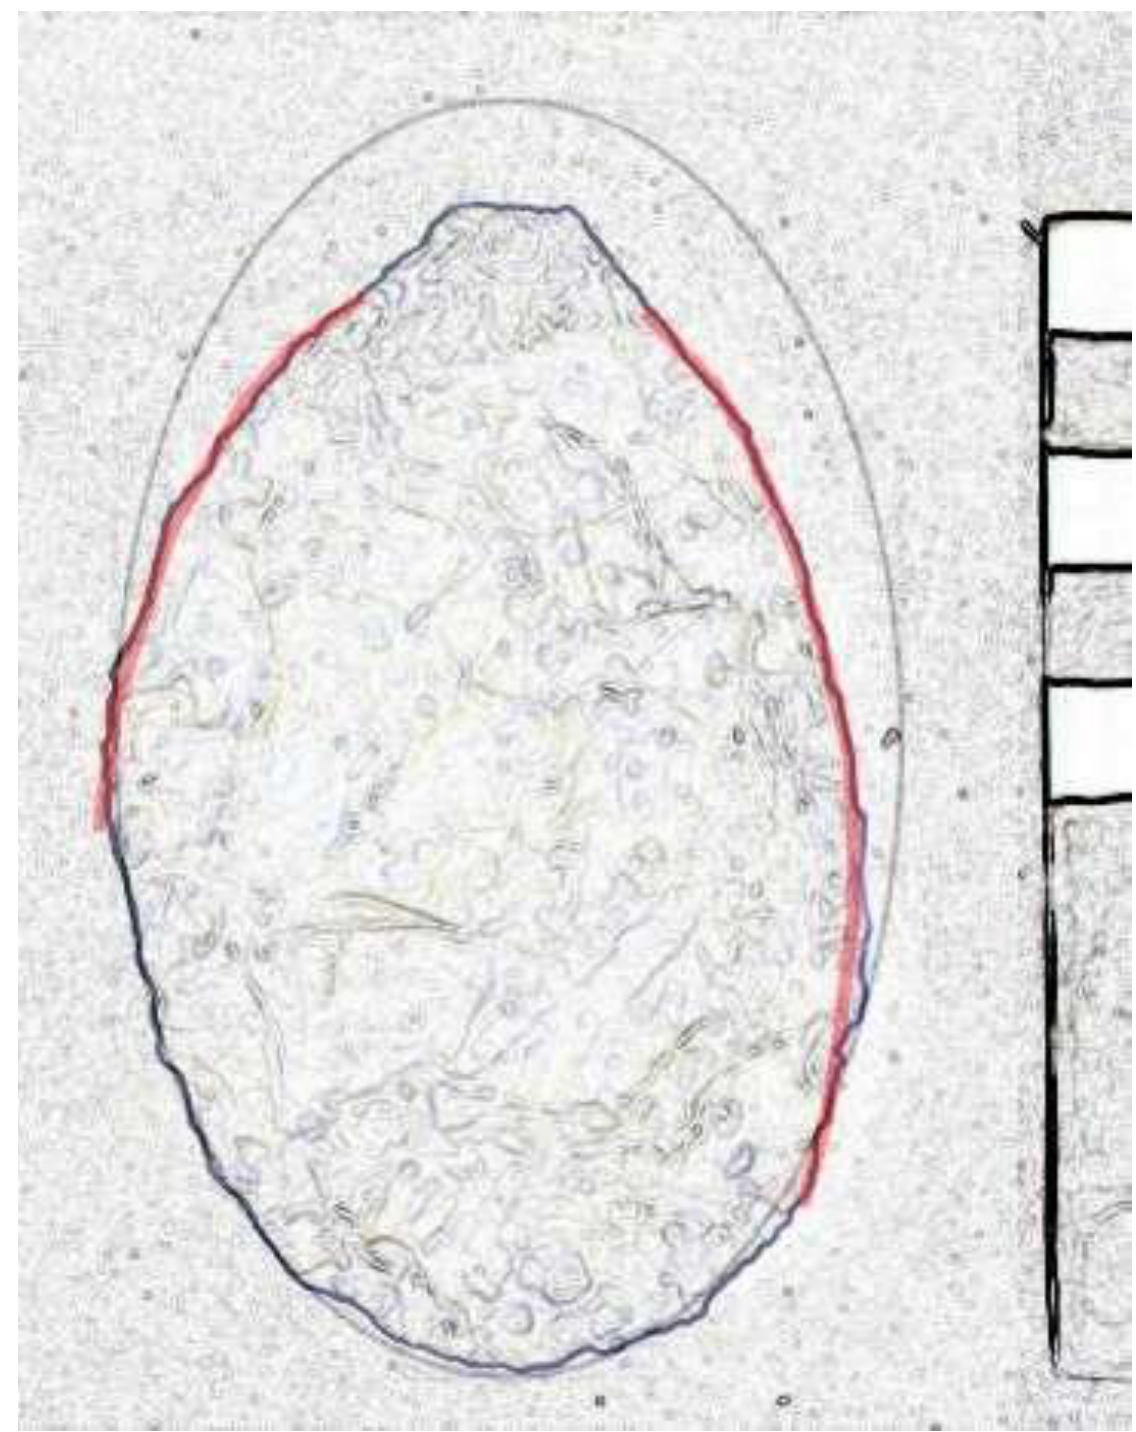
Figure 4. Specimen